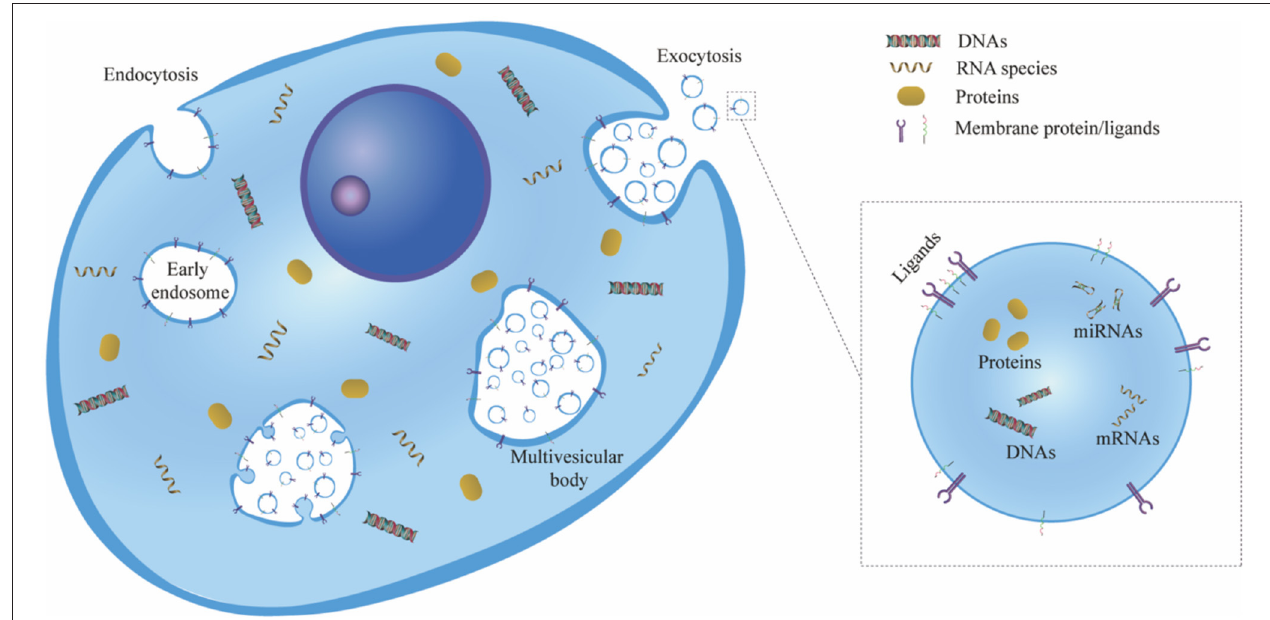
FIGURE 1 | Schematic representation of exosome biogenesis. First, the cell plasma membrane buds inward to form early endosomes via endocytosis. Then, the endosome membrane invaginates and sprouts to form ILVs, and the early endosomes mature and become MVBs. Exosomes are considered ILVs that are released to the extracellular environment owing to the exocytosis of MVBs. ILV, intraluminal vesicle; MVB, multivesicular